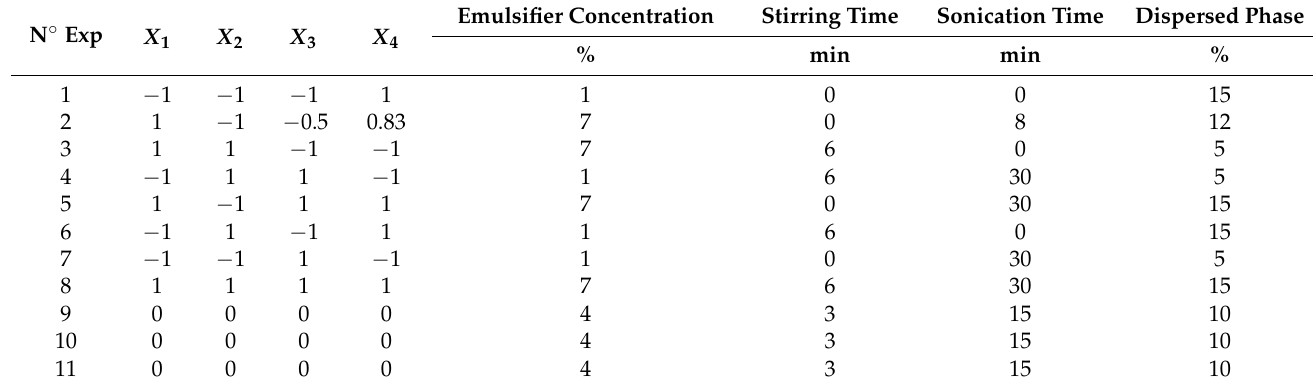
Table 7. Hadamard design of different TEO nanoemulsion